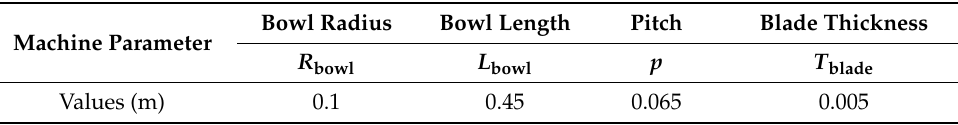
Table 1. Geometries of the hypothetical SBC used in the present work. Machine